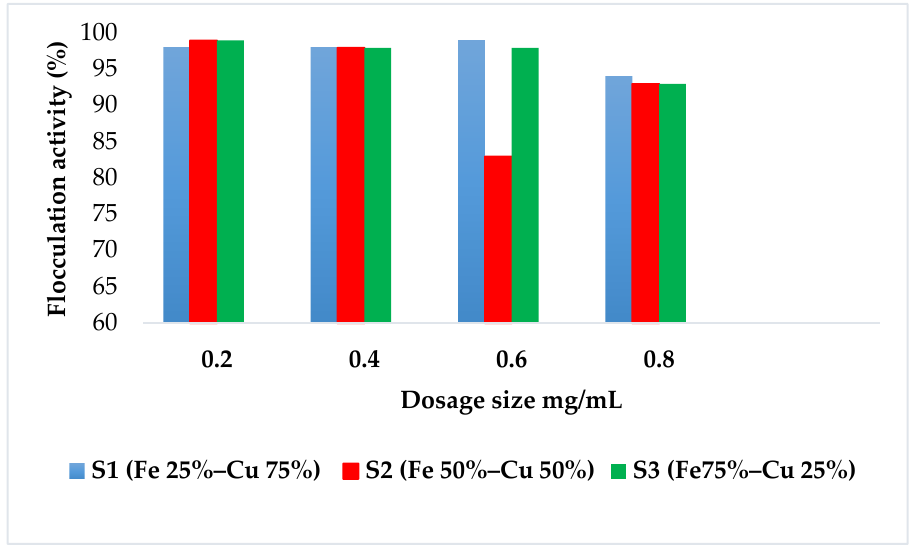
Figure 4. Dosage e ff ect on flocculation activity of nanoparticle samples S1, S2, and S3.